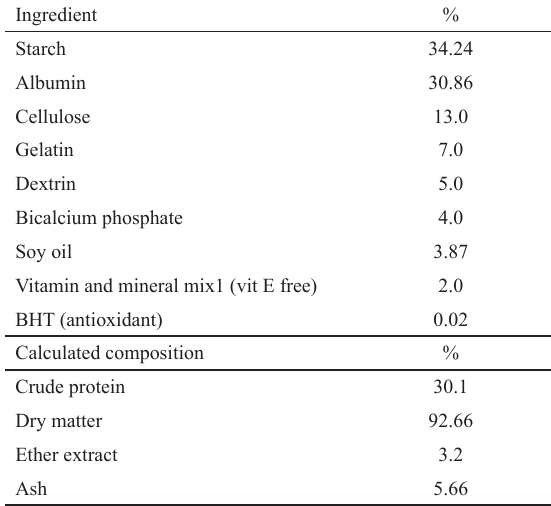
Composition of basal semi-purified diet for P. mesopotamicus